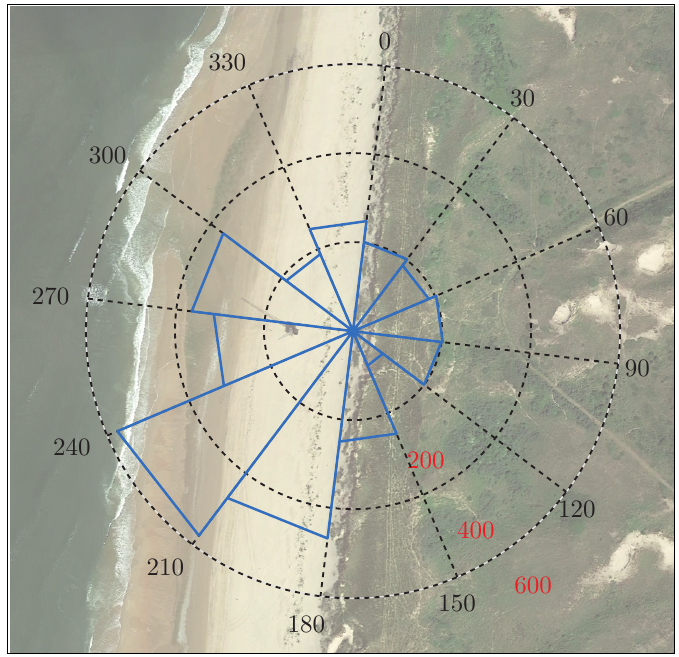
Figure 9. Hourly average wind direction distribution and frequency (red numbers) during the period March 2009–March 2010.